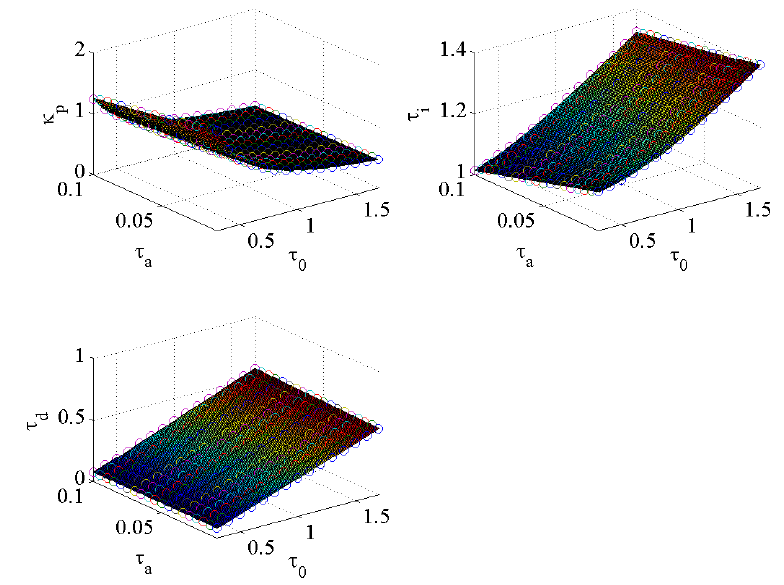
Figure 3. Relationship between approximated controller parameters in servo